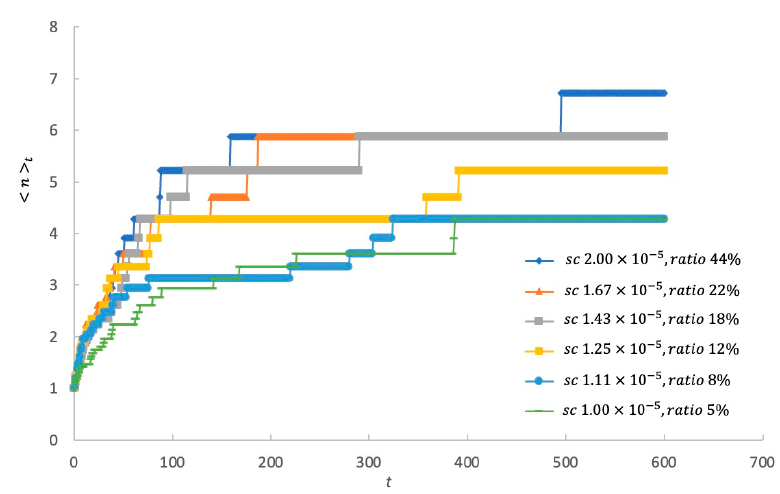
Figure 2. The evolution of average aggregate size with different fluid resolutions (initial distance between fluid particles, sc ; the ratio between the number of solid and liquid particles). The average number of particles per aggregate (cid:104) n (cid:105) and time t along axes were both dimensionless. The unit of t in the x axis is the number of frames for visualization using Ovito software. Here, 600 frames at the end of simulation corresponded to 60 s.